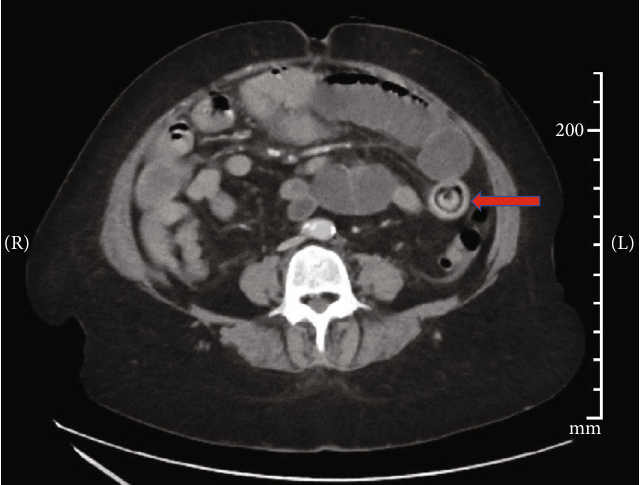
Figure 1: Axial CT demonstrating intraluminal mass causing SBO.